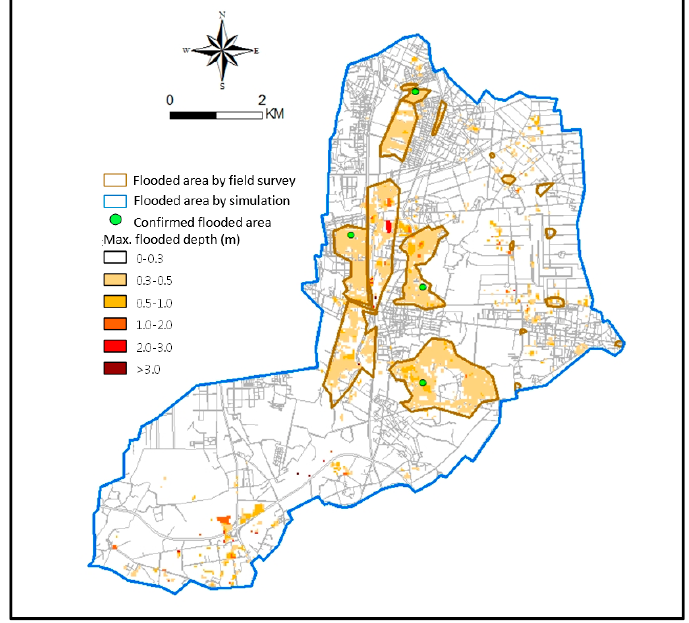
Figure 11. Validation of flood simulation for Sanyeh drainage system after rainstorm occurred on 12 August 2014.